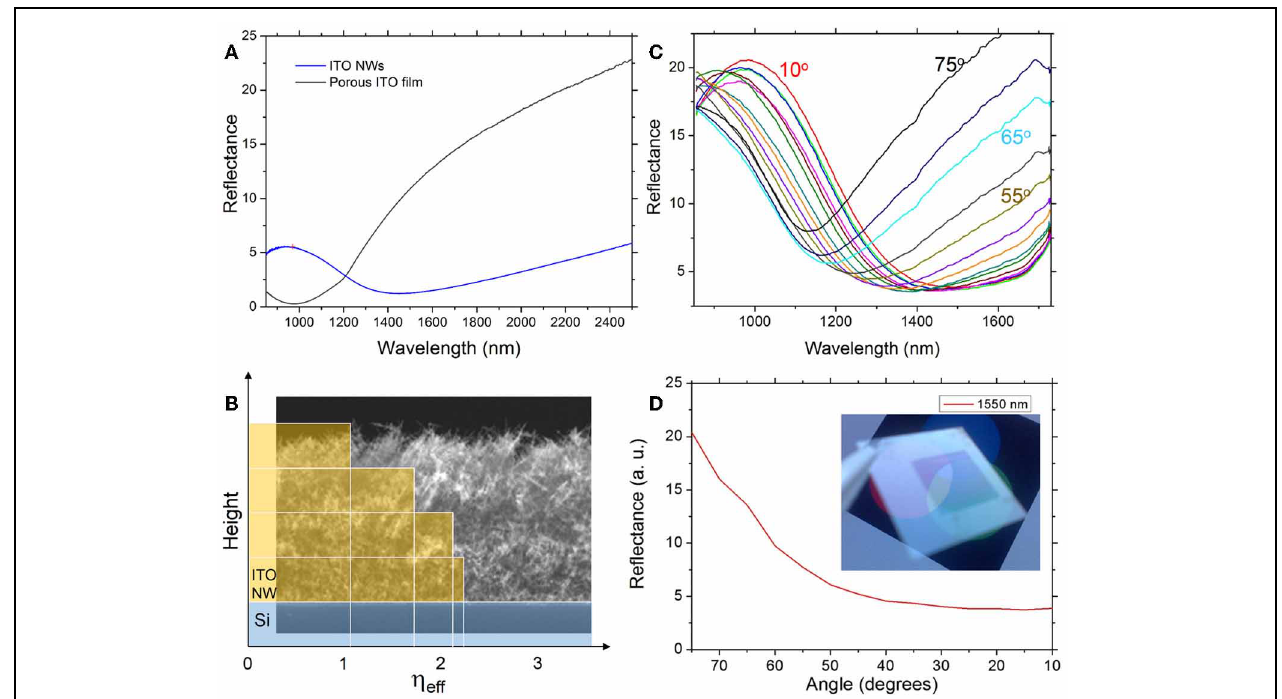
FIGURE 5 | (A) Normal transmission of an ITO NW layer and an MBE grown ITO thin film on glass. (B) Variation of effective refractive index determined from spectroscopic ellipsometry and the Bruggeman effective medium approximation at several stages of NW growth, overlaid on the final structure